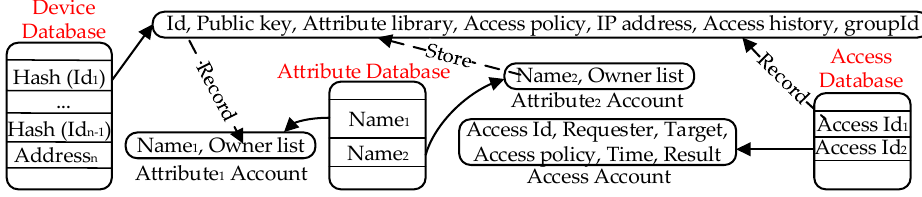
Figure 3. Data structures of the Device Database, Attribute Database, and Access Database maintained by the chaincode. by the